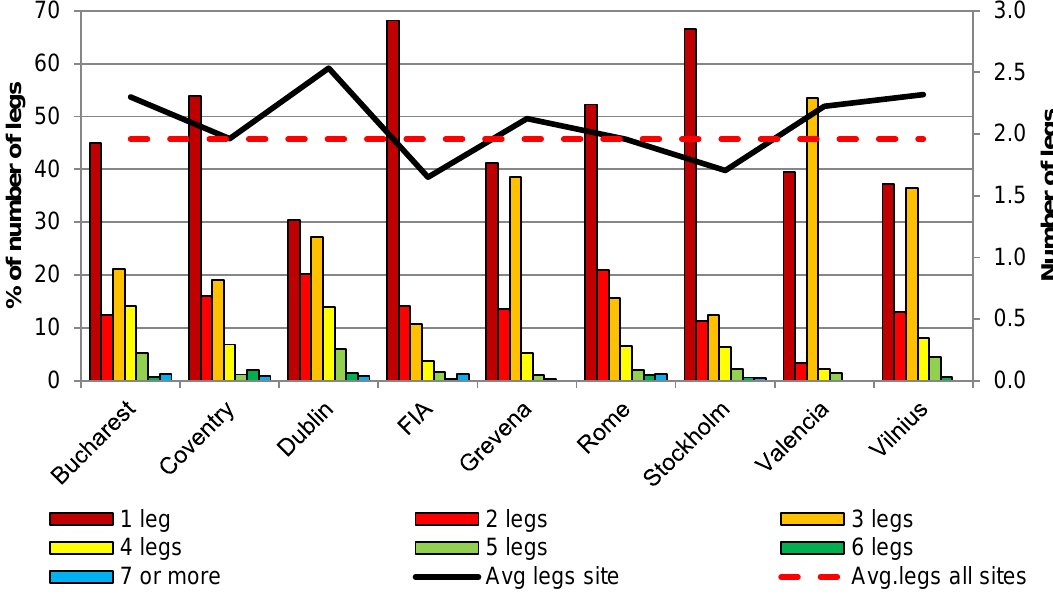
Figure 2. Distribution of reported trip stages by trial sites In terms of reported overall travel satisfaction, on average, communication impaired, visitors and the elderly reported the highest travel satisfaction, whilst commuters, younger travellers and rural dwellers were least satisfied (see Figure 3a). However, across different survey methods, this only applied among respondents who participated in paper based and on-line surveys (the majority of the respondents). Surprisingly, low income travellers reported the highest travel satisfaction via the sbNavi app, whilst travellers with children and the rural dwellers reported the lowest travel satisfactions. Those with communication impairments significantly reported higher travel satisfaction (via focus group methods) than commuters, rural dwellers and women (who reported the